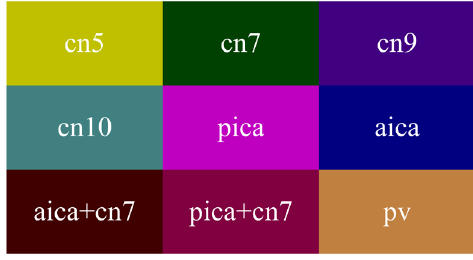
Figure 5. Colormap. Table 2. Abbreviations of medical terms. Table 2. Abbreviations of medical